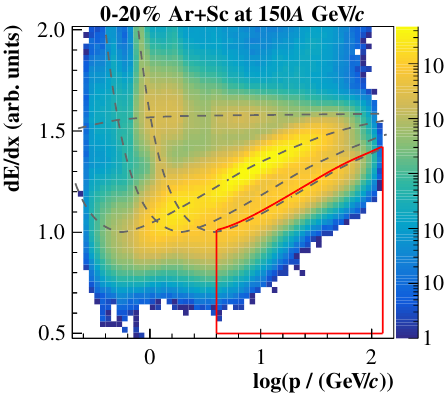
Figure 1. Energy loss vs total momentum of positively charged particles measured with the NA61/SHINE Time Projection Chambers (TPCs) in central 40 Ar + 45 Sc collisions at 150 A GeV/ c . Dashed lines picture the nominal Bethe-Bloch values for protons, kaons, pions and electrons. The cut to select proton candidates is marked with a red